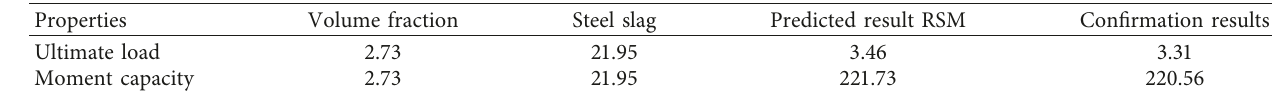
Figure 10: Response optimisation plots: (a) ultimate load; (b) moment capacity. Table 6: Confirmation of Test